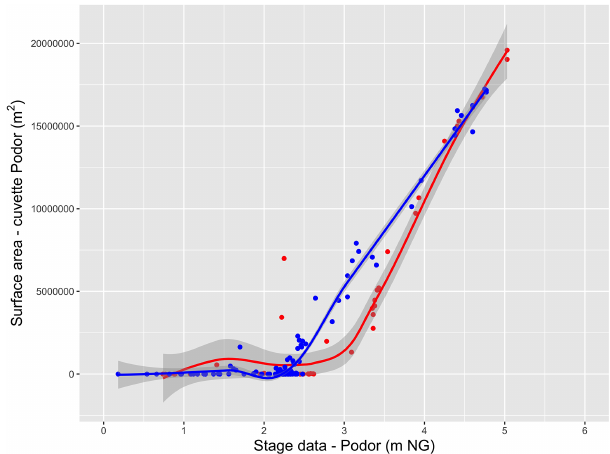
Figure 5. Relationship between stage data at Podor and remotely sensed flooded areas in the Podor floodplain as the flood rises (red line) and recedes (blue line), revealing the strong